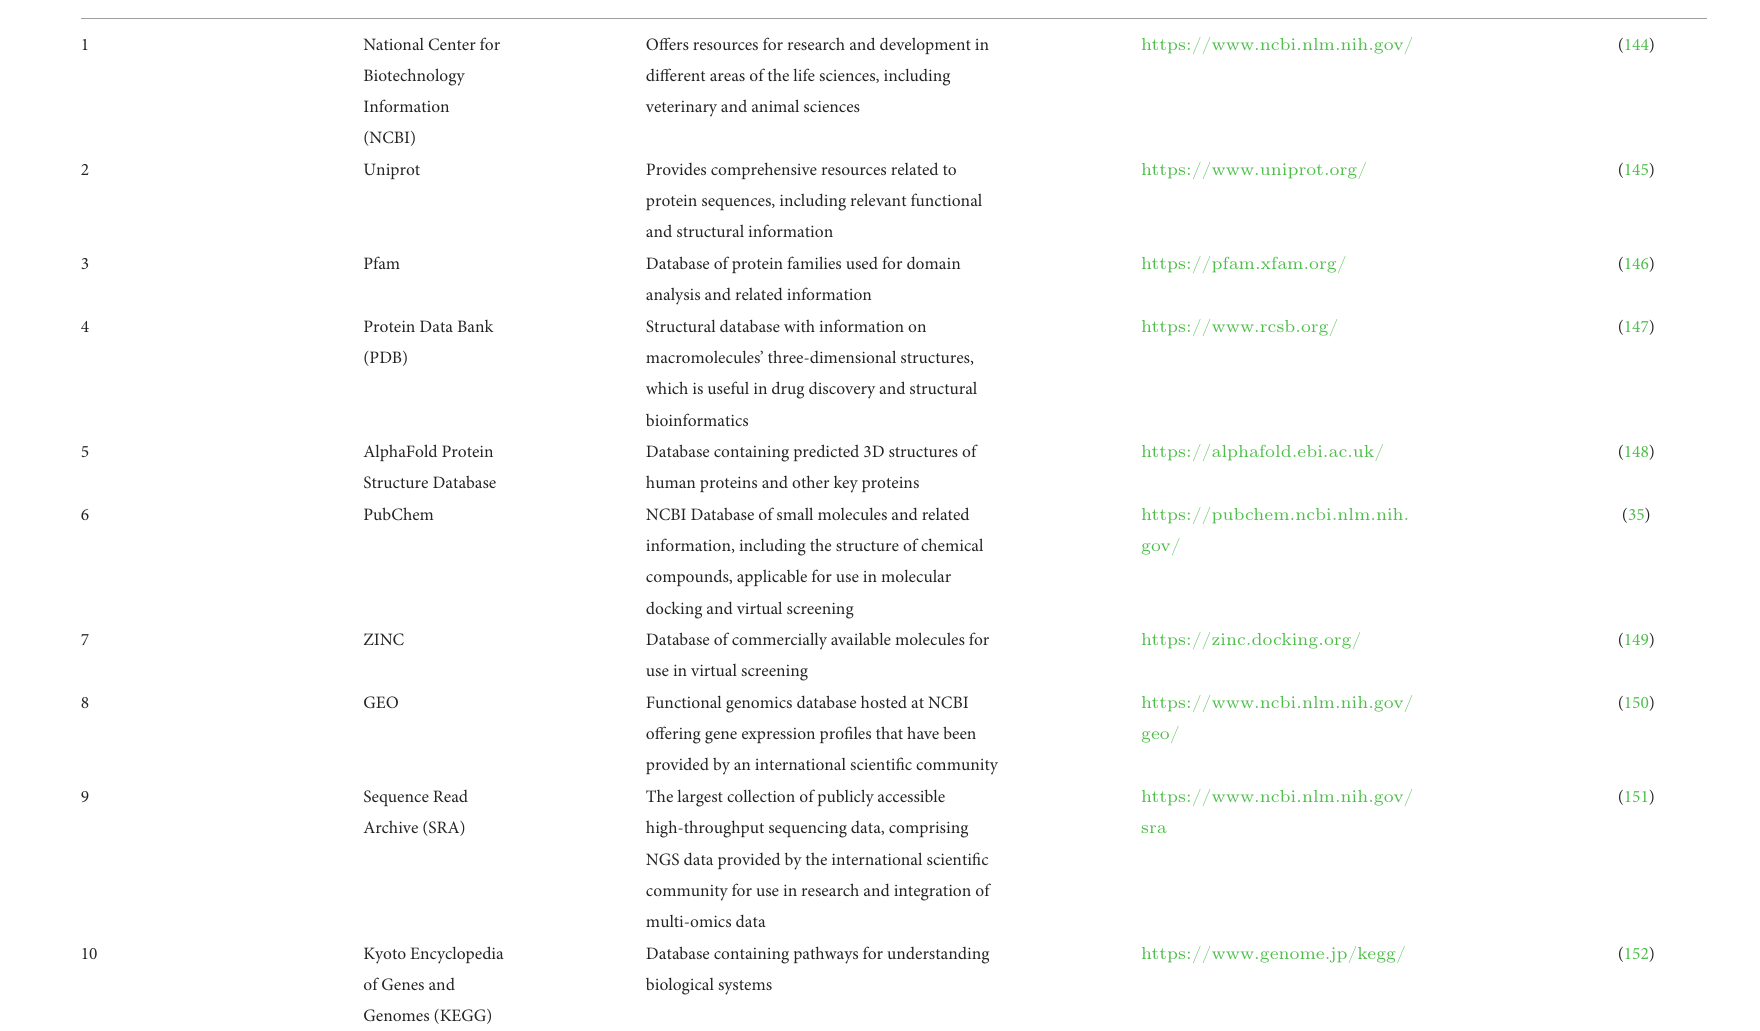
TABLE 1 List of important databases for research in vetinformatics. S.